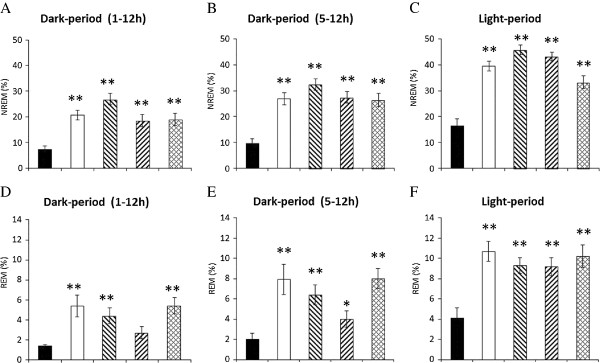
The summary of the effects of naloxone, naloxonazine, naltrindole and nor-binaltorphimine on the EA-induced exacerbation of sleep disruptions. Panels A, B and C demonstrate the percentage of NREM sleep acquired from the indicated time blocks. Panels D. E and F depict the percentage of REM sleep obtained from the indicated time blocks. The bars from the left to the right in each panel represent the data acquired from the PFS + EA + pilocarpine group, the naloxone + EA + pilocarpine group, the naloxonazine + EA + pilocarpine group, the naltrindole + EA + pilocarpine and the nor-binaltorphimine + EA + pilocarpine group. Panels A, B and C represent the percentage of time spent in NREM sleep during the 12-h dark period, the time block between 5-12 h of the dark period, and the 12-h light period, respectively. Panels D, E and F indicate the percentage of time spent in REM sleep during the 12-h dark period, the time block between 5-12 h of the dark period, and the 12-h light period, respectively. **: p < 0.01 vs. the values acquired from the PFS + EA + pilocarpine group.